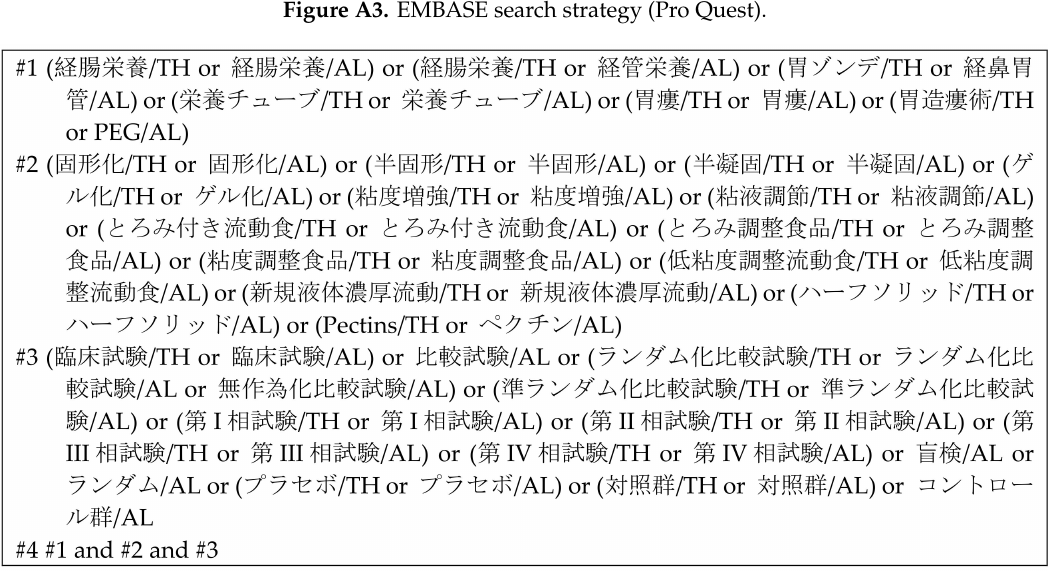
Figure A4. Ichushi-web search strategy.